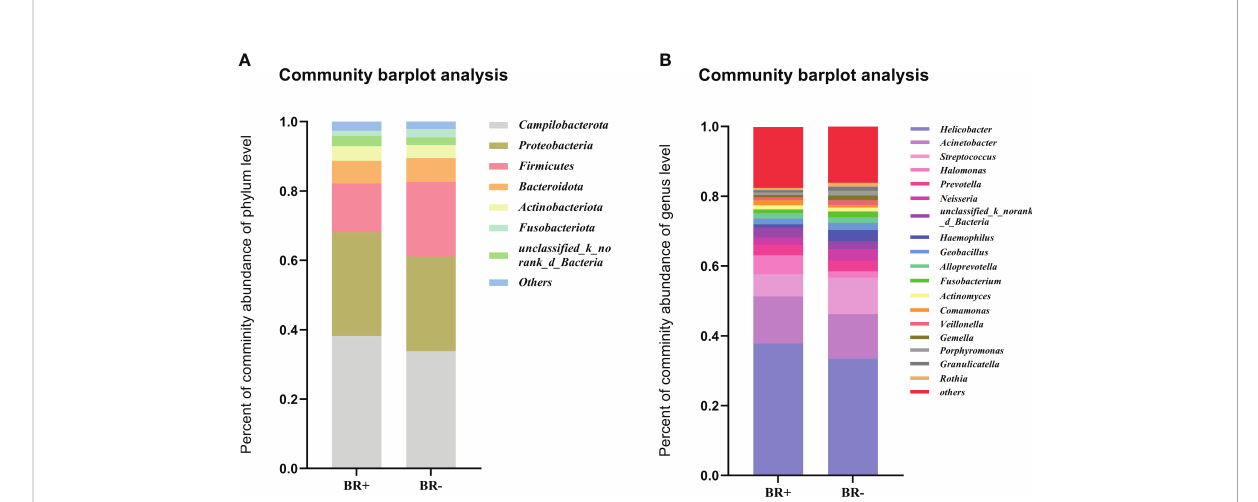
FIGURE 5 The abundance of relative taxa in the gastric microbiota. Comparison of the abundance of relative taxa between the BR+ and BR- groups at the (A) phylum and (B) genus